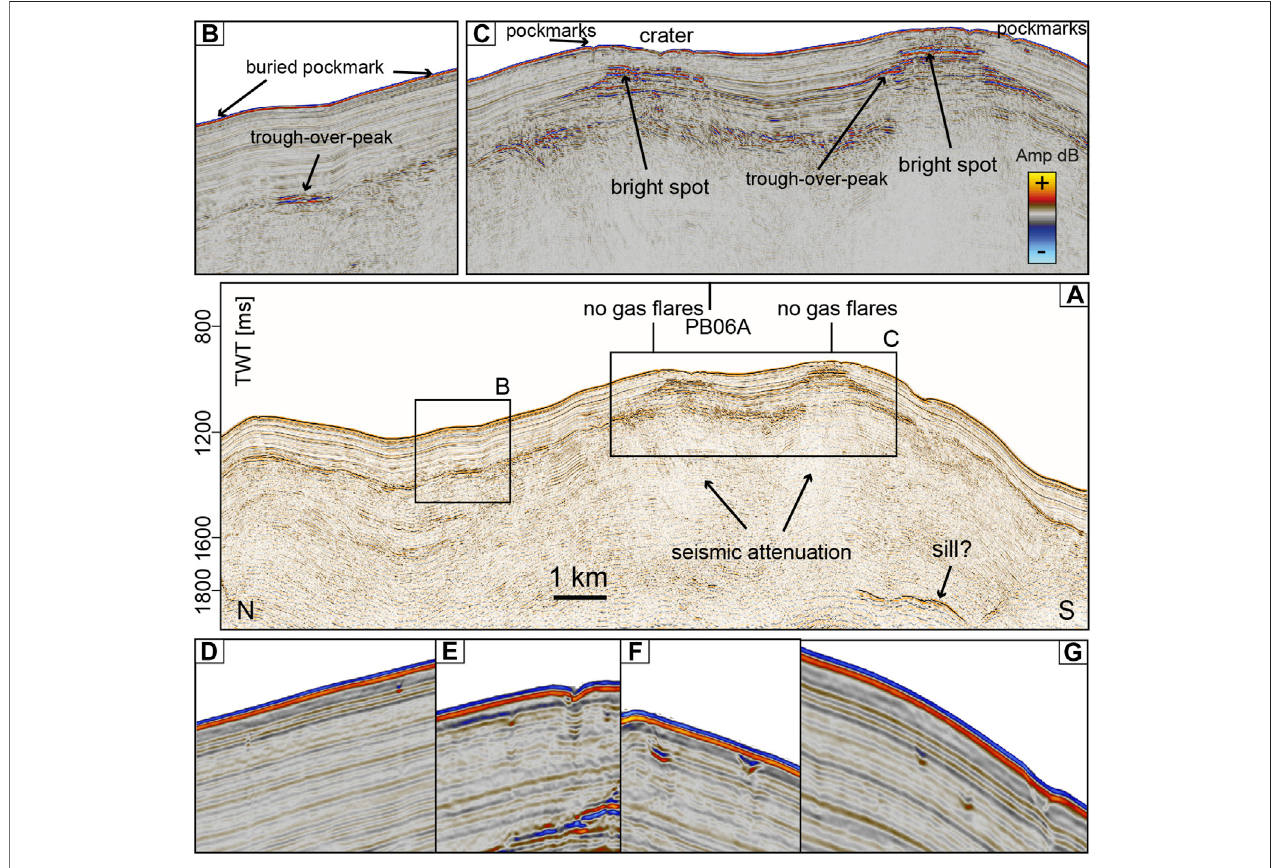
FIGURE7|(A) Seismicre fl ection pro fi le PB04crossing theareabetweenRMVand MMV and showingseismic attenuationunderneath brightspotsand scattered trough-over-peak events located 100 – 150 m below the seabed. Close-up panels of seismics in correspondence of: (B) trough-over-peak events; (C) bright posts connected with the presence of pockmarks and free gas few meters below the seabed. Location in Figure 2A . (D – G) Examples of buried pockmarks.